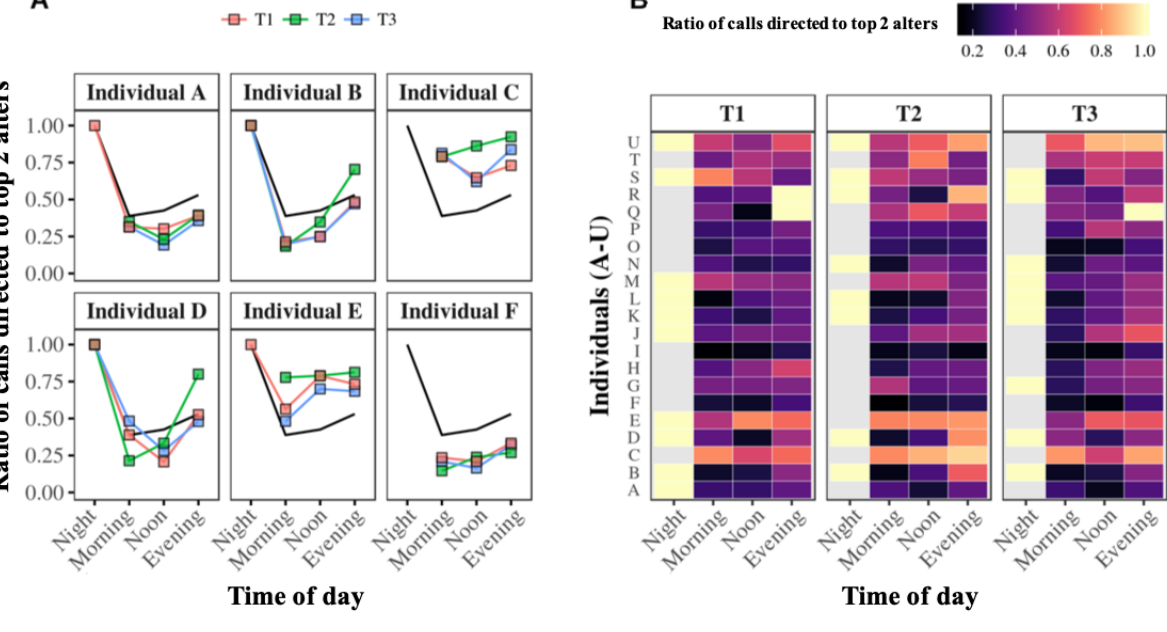
Figure 7. Aggregate-level average call duration throughout the day. Curves represent average call durations from egos to their families (red curve), friends (green curve), health care professionals (purple curve), and clubs or associations (blue